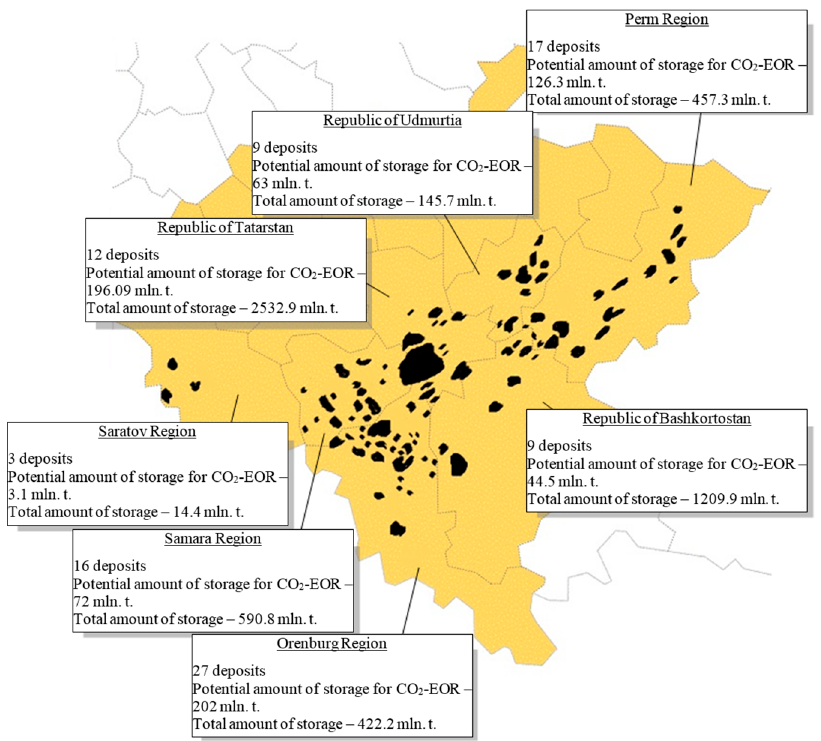
Figure 12. Map of oil deposits of Volga Federal District.